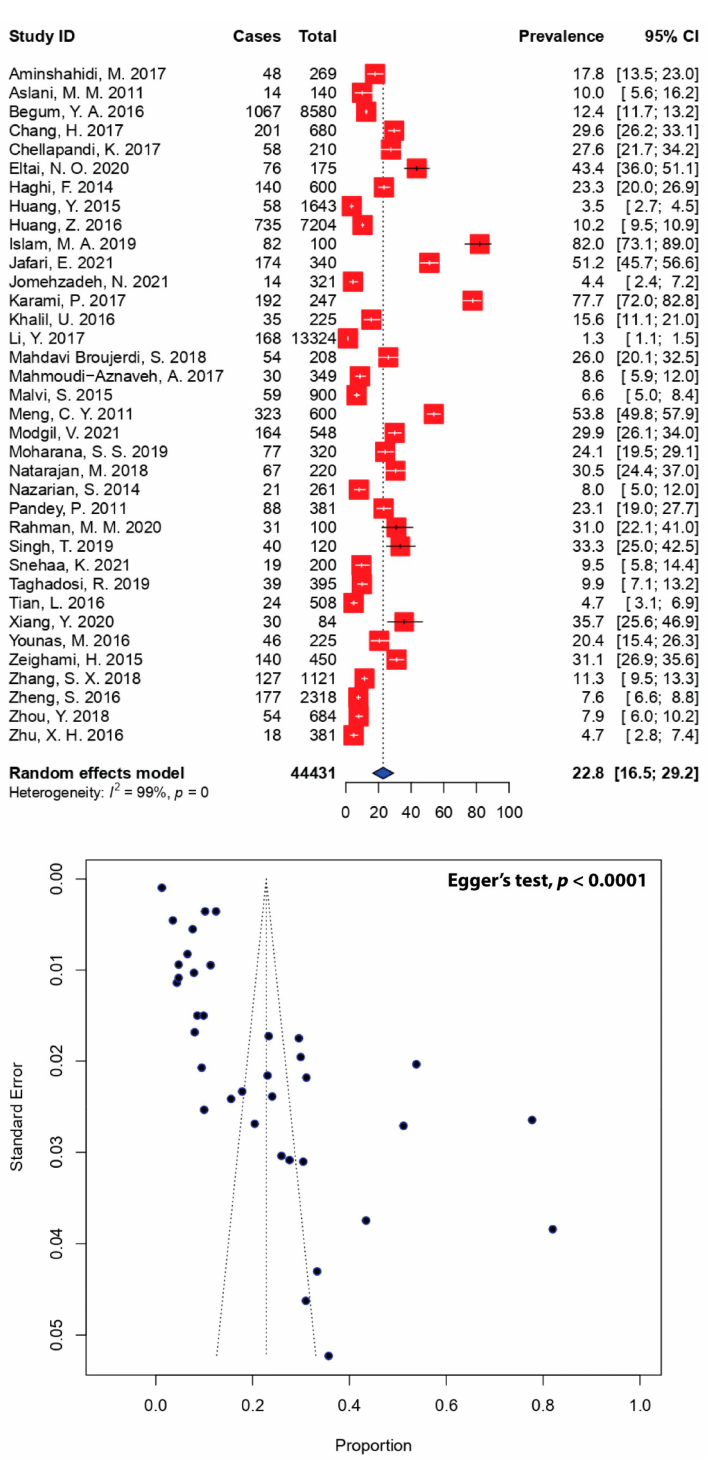
Figure 2. Forest and funnel plots representing the pooled Asian prevalence of DEC. The estimate of prevalence was calculated by pooling 36 selected studies using the random-effects model (top panel). Four studies (Bagus Wasito, E. 2017 [21], Hoang, P. H. 2017 [27], Margulieux, K. R. 2018 [18] and Pazhani, G. P. 2011 [44]) were excluded from the analysis due to the absence of data on the sample population. The distribution of effect estimates is shown by a funnel plot (bottom panel). Figures were generated using R